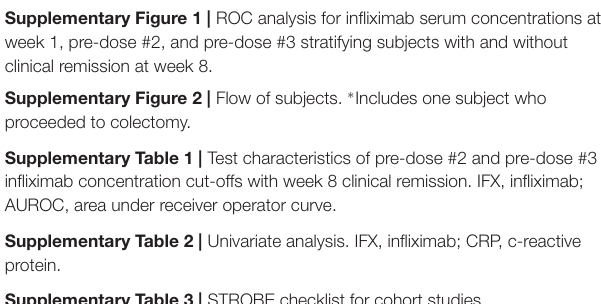
Supplementary Table 3 | STROBE checklist for cohort